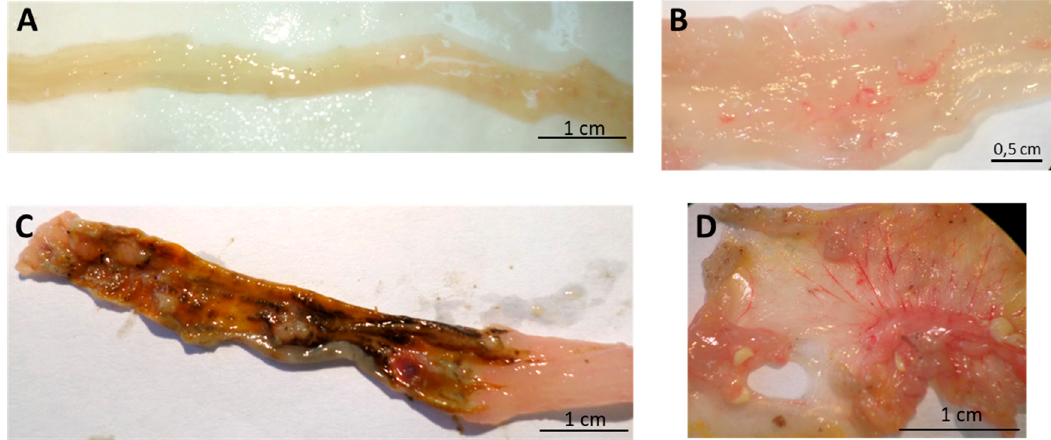
Figure 5. Effect of oral administration of spearmint extract, on the macroscopic evaluation of colon. ( A ) Sham group (n = 4), ( B ) EtOH group (n = 4), ( C ) TNBS group (n = 8), ( D ) TNBS + Spearmint extract group (n = 9).